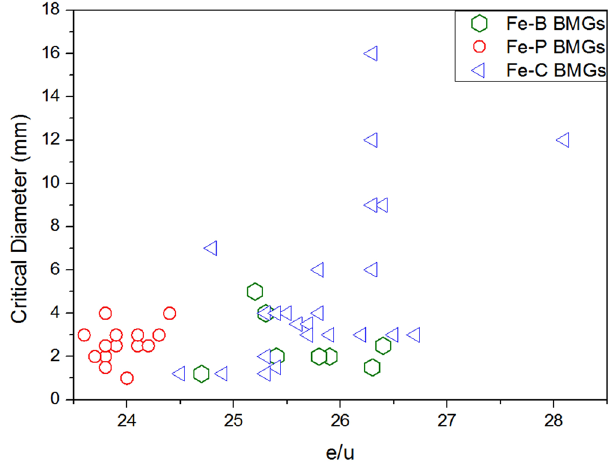
Figure 8. Plot between e/u and critical diameter of Fe-(B,P,C)